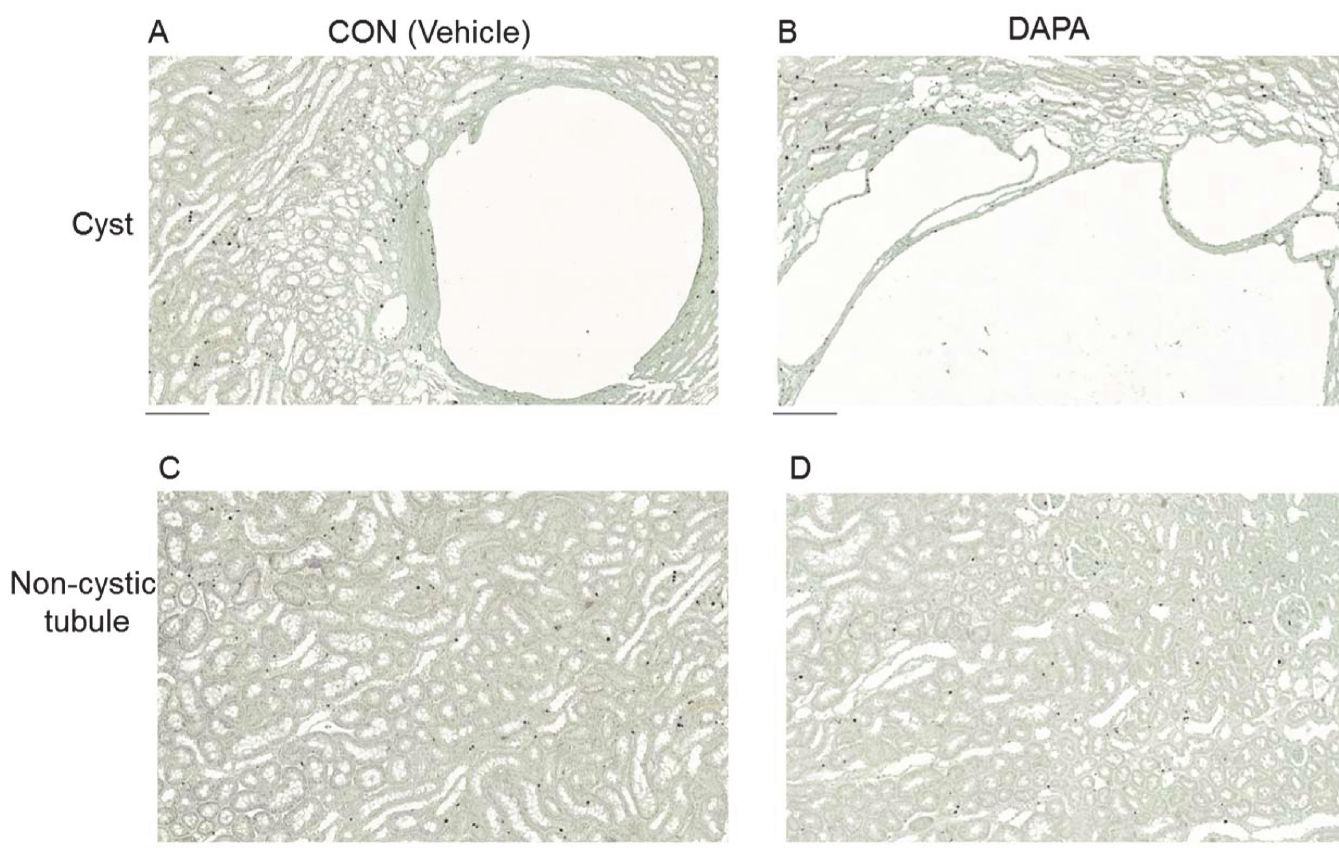
Fig 7. Effect of DAPA on cell proliferation. Representative areas of Ki67 immunohistochemical staining in PCK rat kidneys are shown. Nuclei of Ki67-positive cells were stained brown with 3,3 ’ -diaminobenzidine and that of Ki67-negative cells appeared blue because of the counterstaining with hematoxylin. CON (cystic area) (A), DAPA (cystic area) (B), CON (non-cystic area) (C), DAPA (non-cystic area) (D). Scale bar is 200 μ m in A, B, C and D.